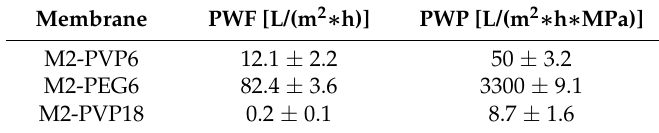
Table 5. PWF and PWP values for the membranes M2-PVP6, M2-PEG6, and M2-PVP18.